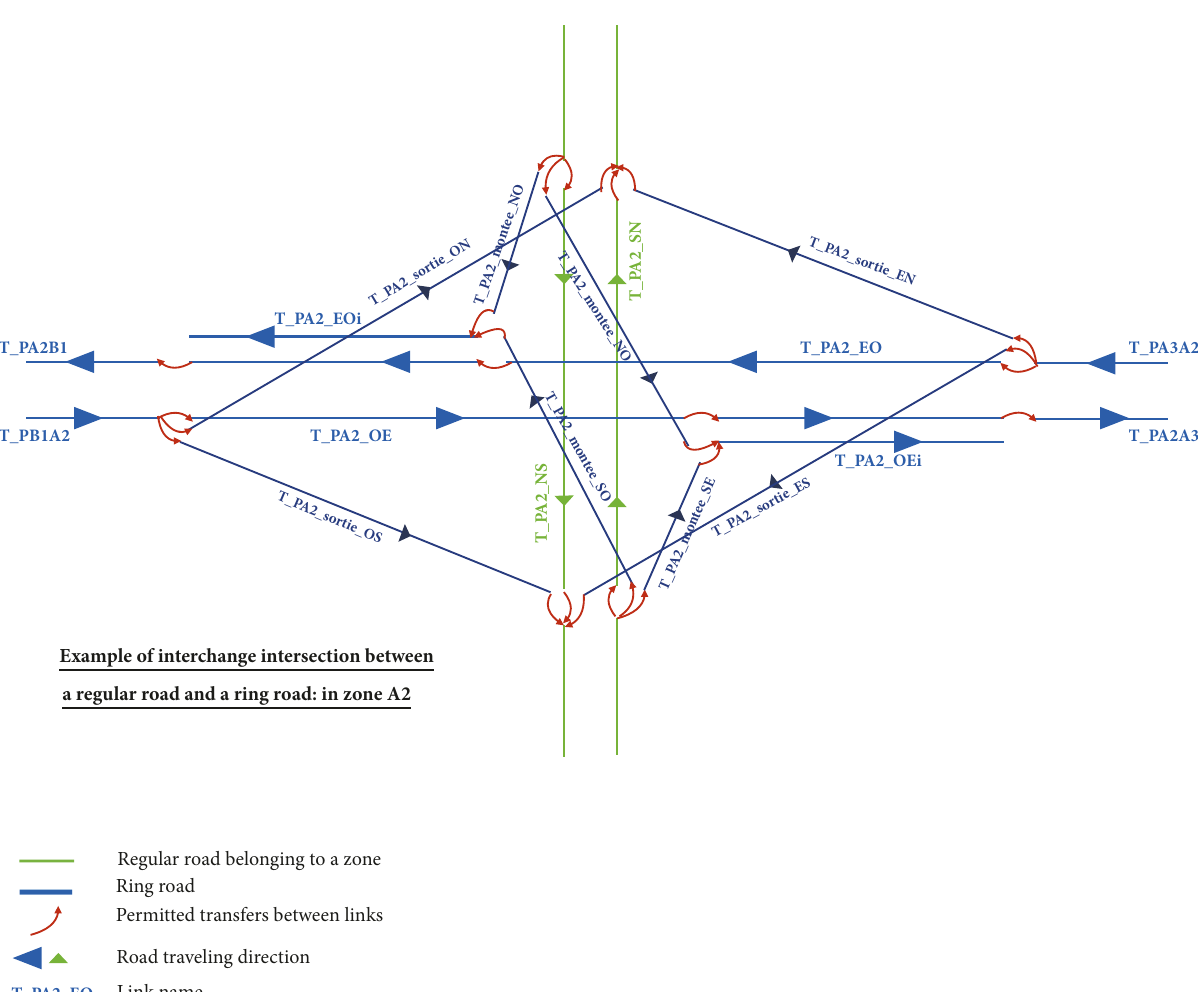
Figure 18: Details of an interchange